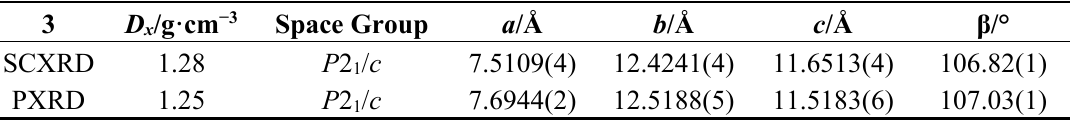
Table 5. Comparison of lattice parameters determined at 173 K (single crystal X-ray diffraction data) and 298 K (powder X-ray diffraction data).